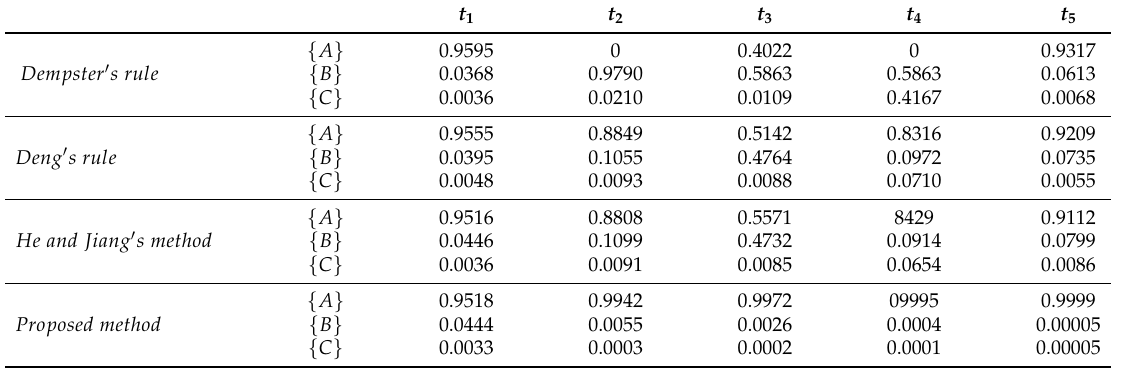
Table 6. Simulation results when the target moves along curves.